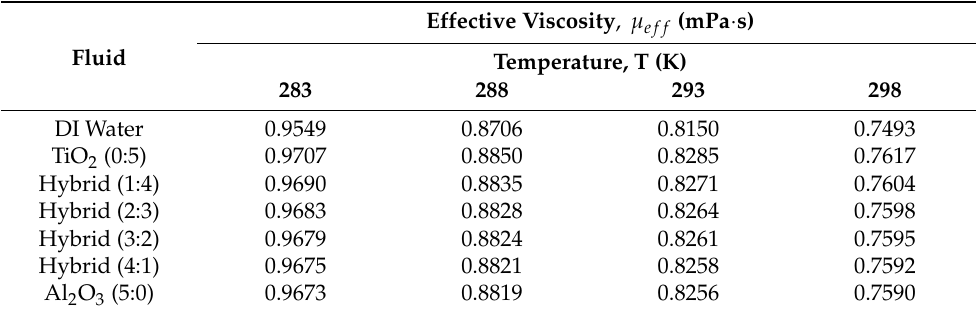
Table 7. Effective viscosity ( µ ef f ) of hybrid nanofluid having different particle ratios at a specific